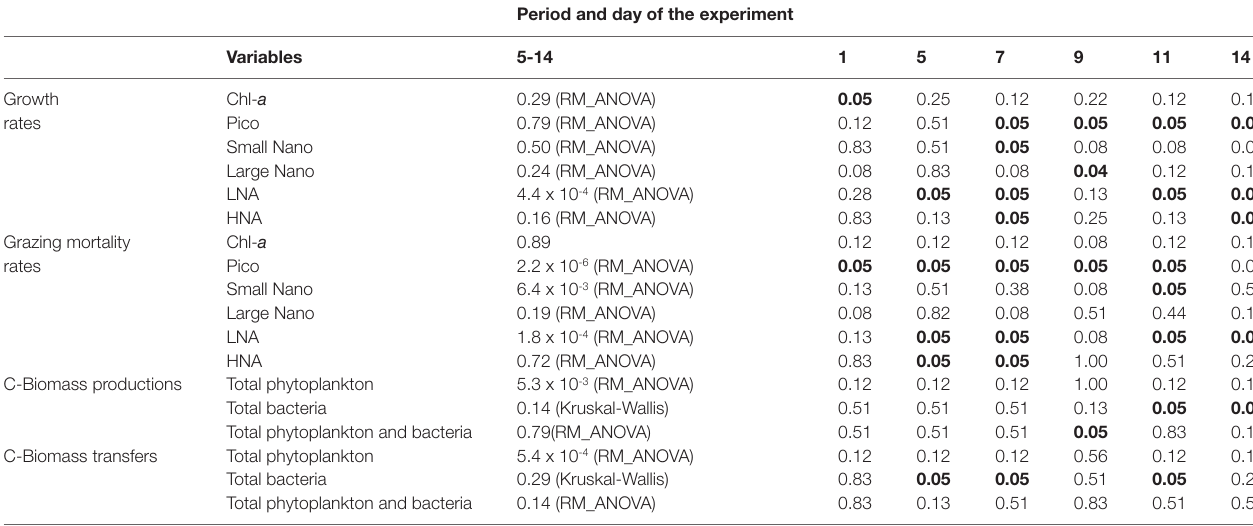
TABLE 2 | Summary table of the p-values of the statistical comparison performed between the control and warmed treatments for the growth, grazing mortality rates, carbon biomass production and transfer of different phytoplankton and bacteria groups for each dilution day (days 1, 5, 7, 9, 11 and 14). RM-ANOVA was performed from days 5 to 14.